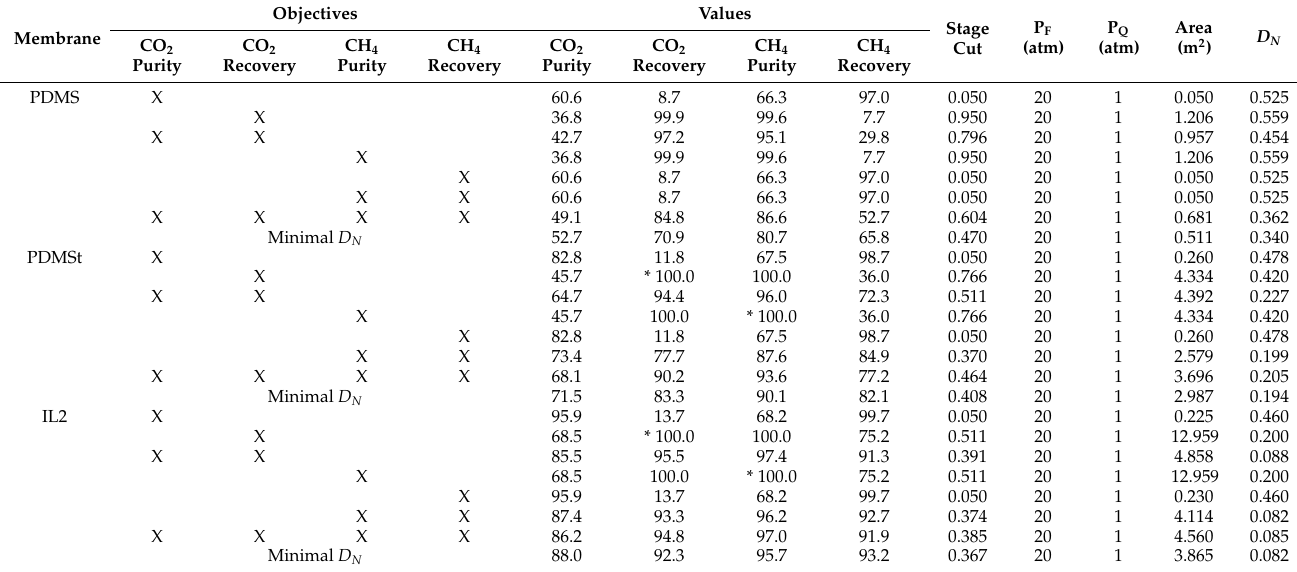
Table 4. Process performance parameters under optimal conditions (considering different objectives) of the PDMS, PDMSt and IL2 membranes (pressurized feed at 20